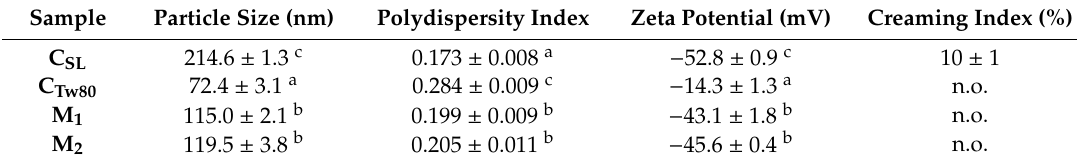
Table 3. Physical properties of nanoemulsions elaborated with different emulsifier mixtures and control samples elaborated with a single emulsifier.